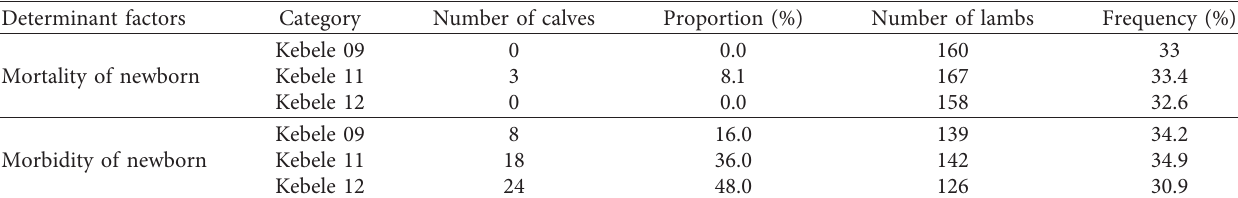
Table 2: Distribution of mortality and morbidity of newborn calf and lamb across the study villages.